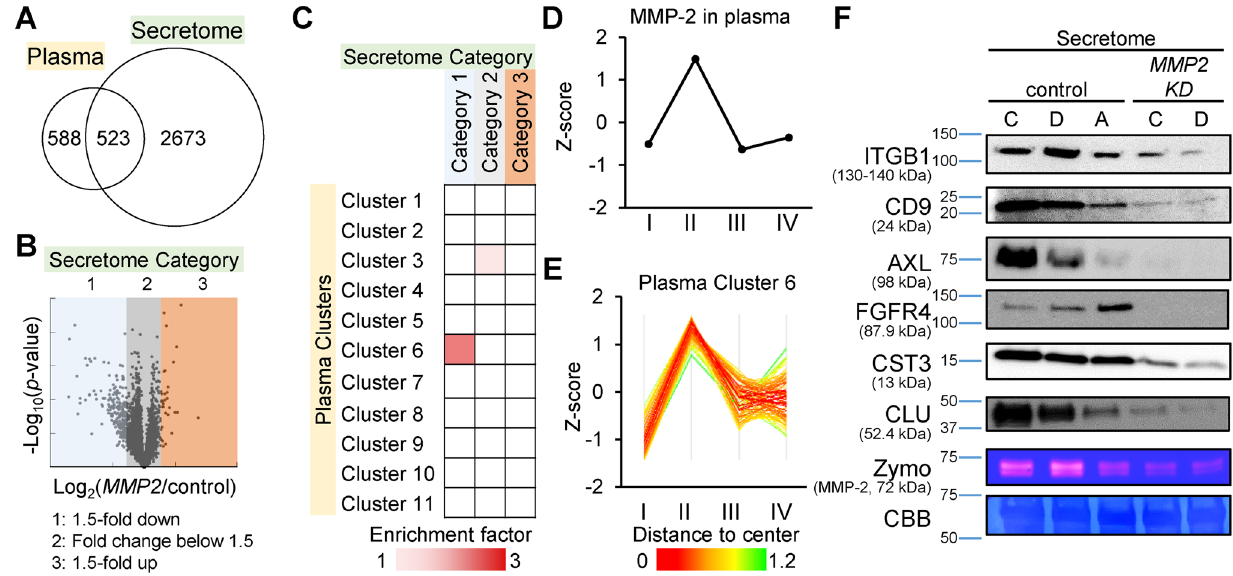
Figure 3. Comparative analysis of the cell secretome with the plasma proteome of CRC cancer patients. ( A ) The numbers in the Venn diagram represent those of identified proteins. ( B ) The HCT116 secretome was divided into 3 categories based on log 2 ( MMP2 KD/Control) ratio. ( C ) Fisher’s exact test between the three secretome categories and 11 plasma clusters (Benjamini–Hochberg FDR < 0.02). Color intensity represents the enrichment factor for the association between the secretome and plasma clusters. ( D ) Z-scored expression profile of MMP-2 in plasma proteome according to CRC stage. ( E ) Z-scored expression profiles of proteins in the plasma cluster 6. ( F ) Western blot analysis of the proteins commonly identified in both secretome category 1 and plasma cluster 6. Protein samples were prepared from the conditioned media (10 µg) of HCT116 Control and HCT116 MMP2 KD. C Control, D DMSO-only, A ARP-100 treated. Full-length blots are available in supplemental